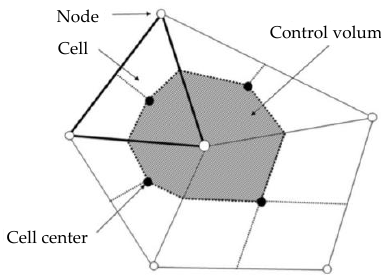
Figure 16. Conceptual diagram of finite volume method.